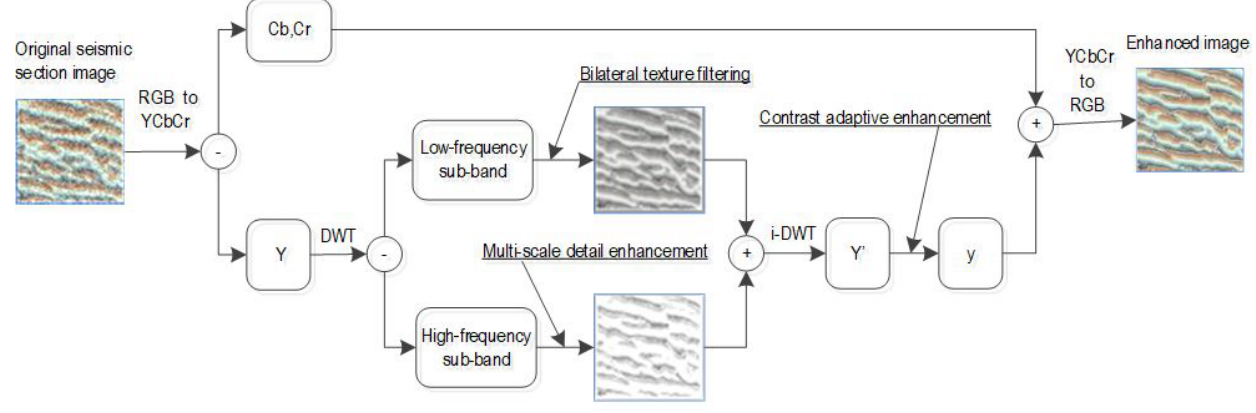
Figure 1. Process of seismic section image detail